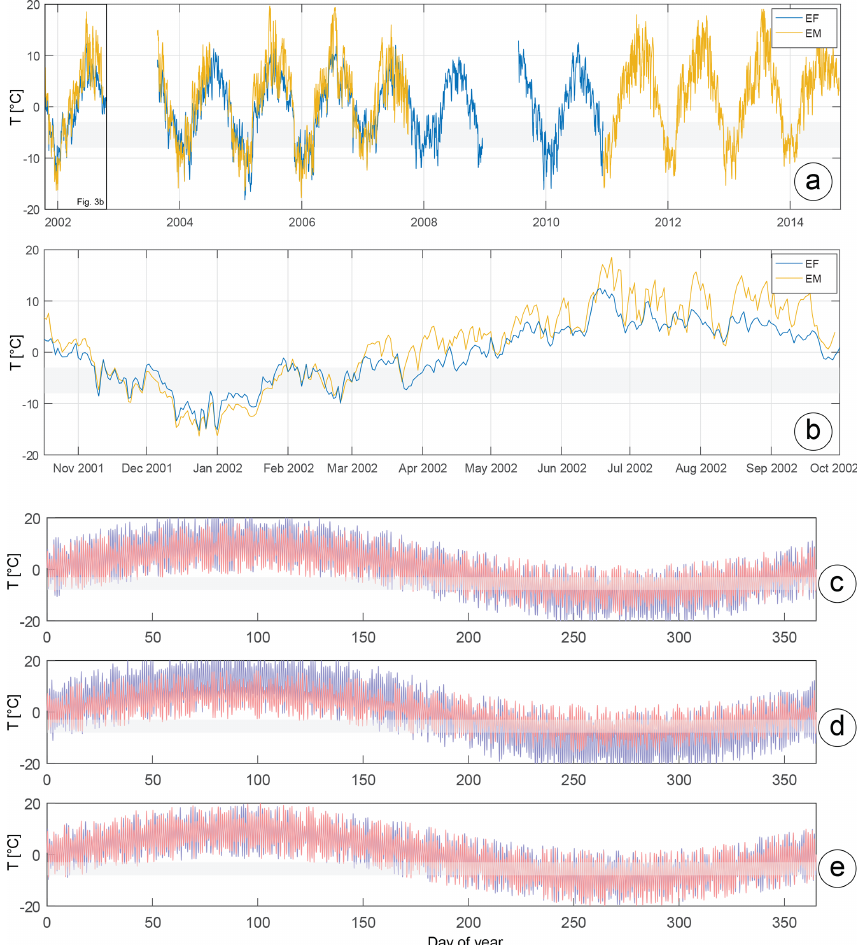
Figure 3. (a) Complete daily averaged PERMOS (2019) temperature data for the upper NW (EF) and the SE sites (EM). (b) Daily averaged temperature data for the hydrological year 2002. Data displayed in panels (a) and (b) were used in this study to estimate d T a and d T d . For modern min, mean, and max estimations only complete years were used. Synthetic temperature curves which were used for the frost cracking model for the upper NW (blue) and SE (red) sites for modern mean (c) , modern minimum (d) , and modern maximum conditions (e) . Shaded area corresponds to a frost cracking window of − 3 to − 8 ◦ C. See text for